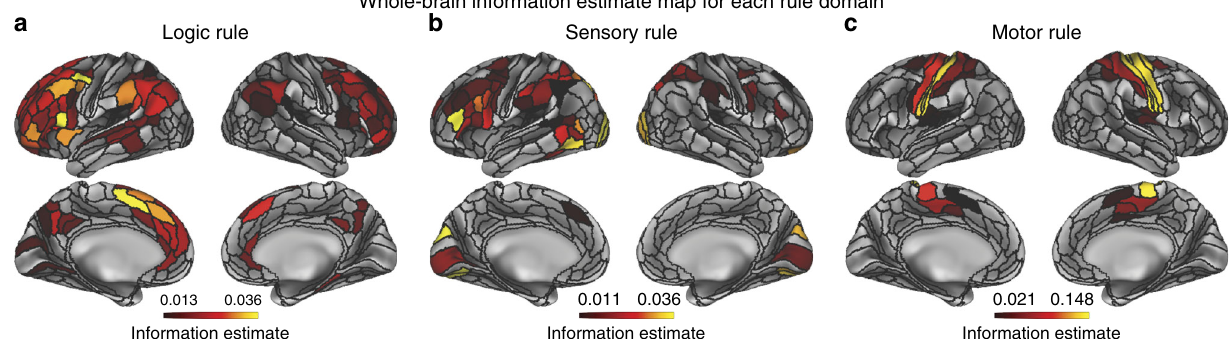
Fig. 5 Information estimates of each region for each task-rule domain, prior to information transfer mapping. All reported results were statistically signi fi cant at FWE-corrected p < 0.05. a Thresholded whole-brain logic rule information estimate map. A cross-validated representational similarity analysis (quantifying degree of information representation; see Methods) for the logic rule domain was computed using vertices within every region. For each region, an average information estimate was computed for each subject, and a one-sided t -test was computed against zero across subjects. b Thresholded whole-brain sensory rule information estimate map. As in the logic rule analysis, rule representations were highly distributed across the entire cortex, though representations were especially prominent in visual areas. c Thresholded whole-brain motor rule information estimate map. Unlike the logic and sensory rule representations, motor rule representations were more localized to the motor/tactile